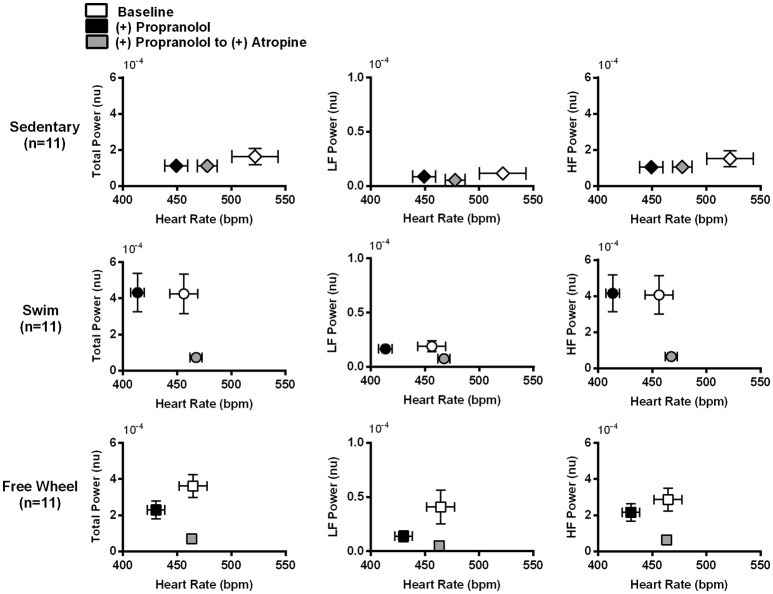
Change in HRV as a function of HR induced by SNA blockade followed by PNA blockade. Plots of the TP, LF, and HF HRV, corrected for HR, as a function of HR at baseline (no drug), after propranolol, and after propranolol plus atropine. Propranolol administration reduced HR without affecting TP, LF, or HF HRV in exercised as well as sedentary mice. The subsequent administration of atropine, in the presence of propranolol, reduced TP (P < 0.005) and HF (P < 0.007) HRV while increasing (P < 0.001) HR in both exercise groups, similar to the responses to atropine in the absence of SNA blockade. Atropine had no measurable (P = 0.961) effect on HRV in sedentary mice despite also increasing HR. After complete cardiac autonomic blockade (propranolol + atropine), HR differences between groups were eliminated (P > 0.301). Data are presented as mean ± SD.